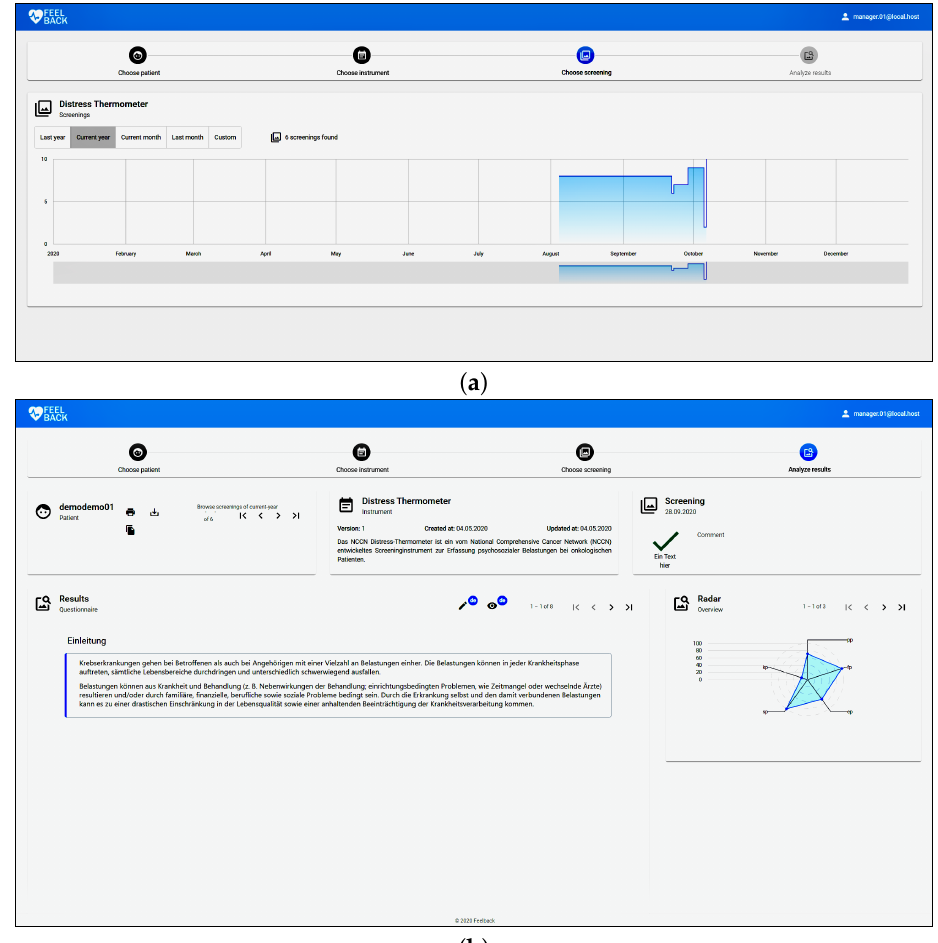
Figure 5. Screenshots of the monitoring application. ( a ) Shows the psychological distress for one particular patient across time to provide a high-level overview for the health care provider. ( b ) Shows the data for one particular screening entry. More precisely the psychologist can review given answers and get visual feedback about the patients psychological condition at that time (i.e., emotional problems, personal problems,